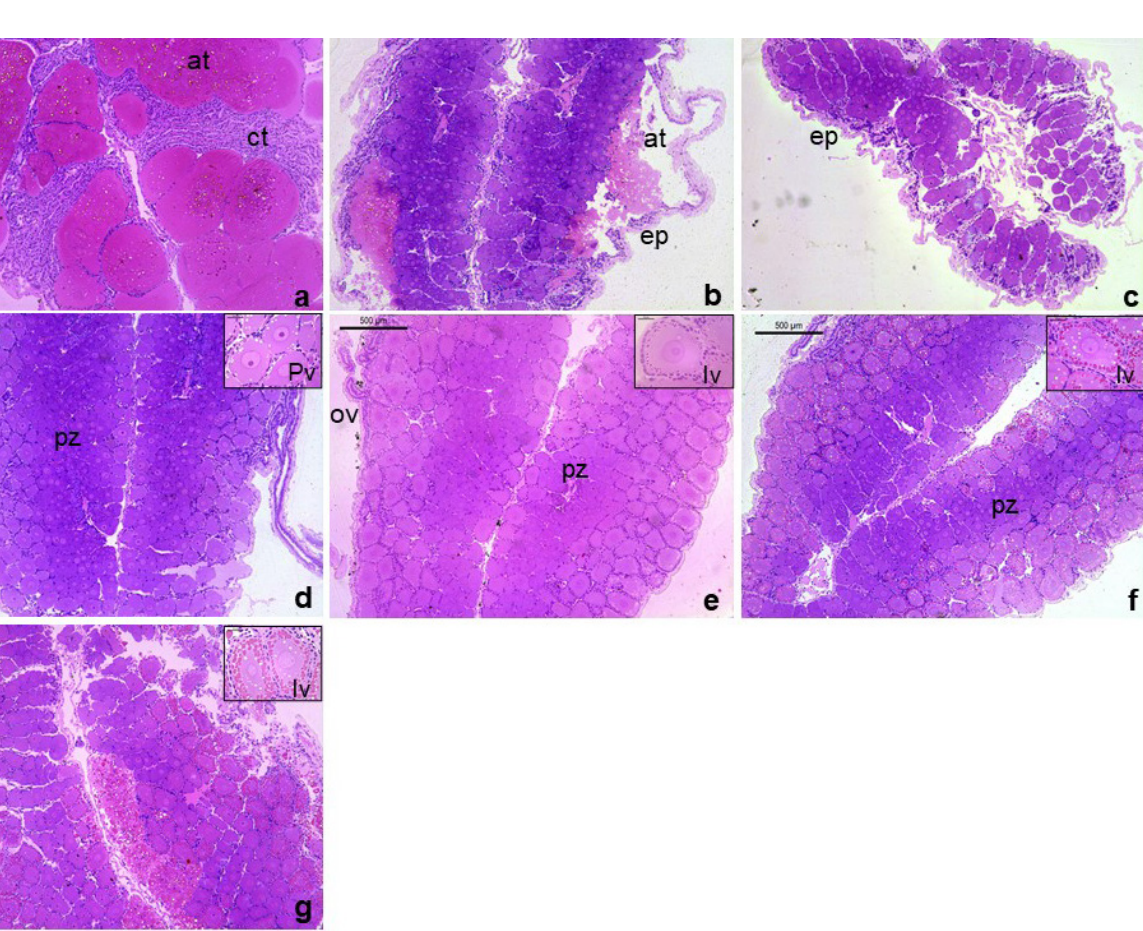
Figure 3. Oocyte development of Macrobrachium acanthurus from oocyte deposition. a) Day of spawning, observe the atretic oocytes and much connective tissue; b) 1 day after spawning, still disorganized “loose” ovary with few atretic oocytes and most oocytes in early vitellogenesis; c) 2 days after spawning, atretic oocytes are no longer present; d) 3 days after spawning, well-organized ovary, beginning lipid storage in the periphery of previtellogenic oocytes; e) 4 days after spawning, oocytes in vitellogenesis initiating a fine peripheral yolk granulation; f) 5 days after spawning, many oocytes in vitellogenesis; g) 6 days after spawning, oocytes in vitellogenesis presenting larger amount of yolk granules. Staining: Hematoxylin-eosin (H-E). Atretic oocytes – at; connective tissue - ct; epithelial tissue - ep; oocyte in vitellogenesis - Iv; oviduct- ov; previtellogenic oocyte - Pv; proliferative zone - pz. 4x (a-g), 40x